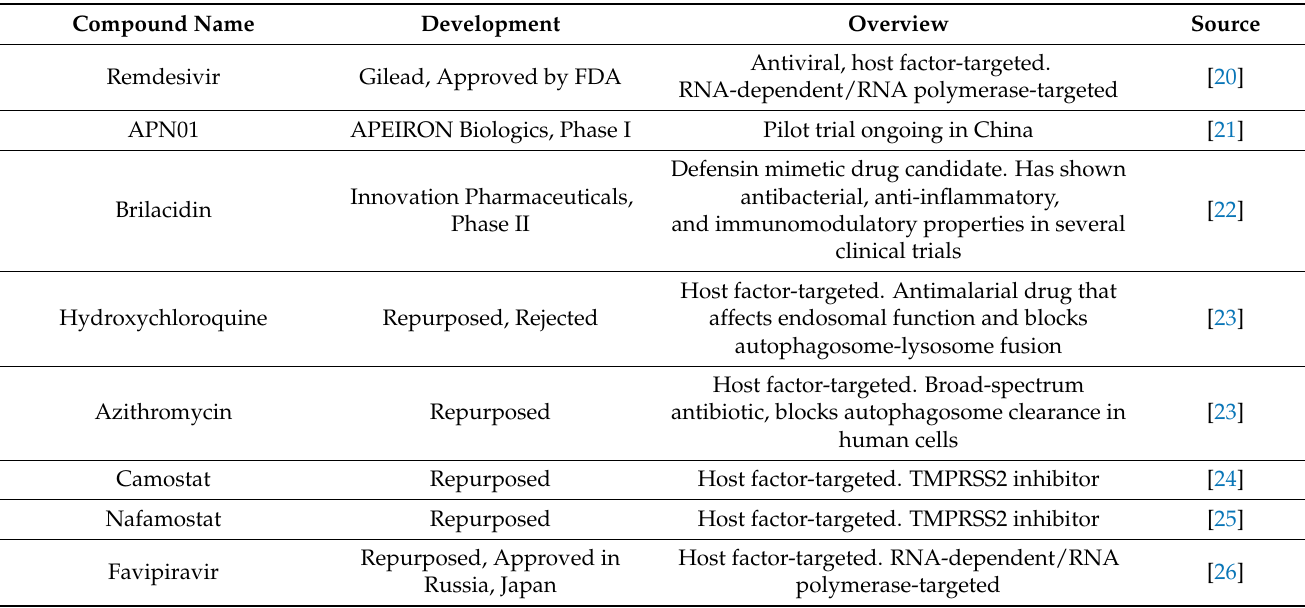
Table 1. Select compounds currently in clinical trials for treating